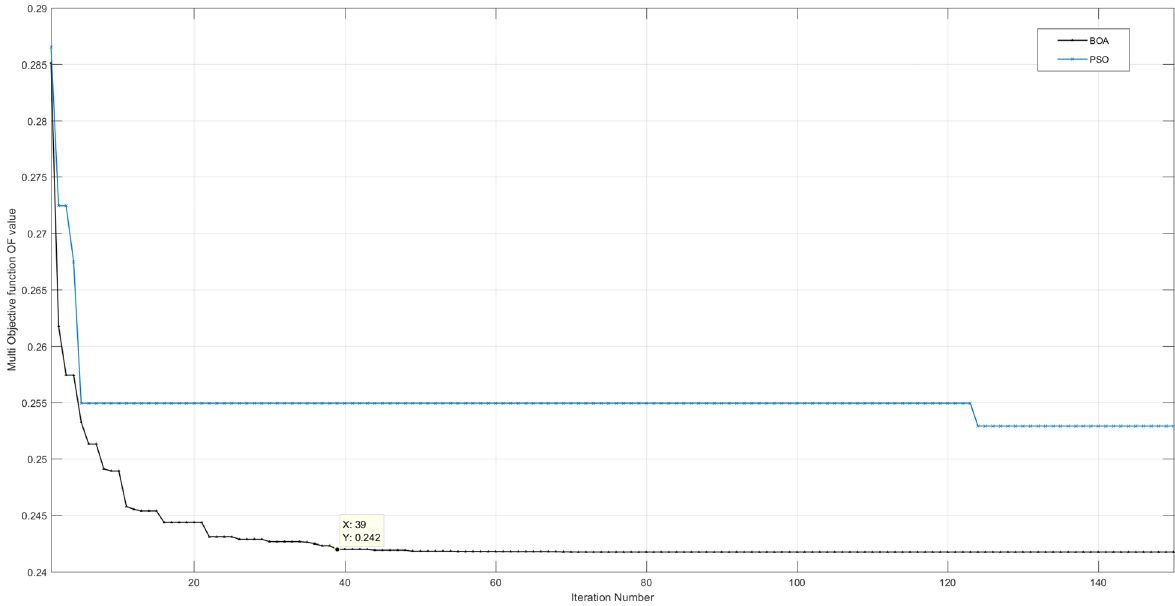
Fig. 11 Convergence graphs of BO and PSO algorithms for optimal placement of DGs at